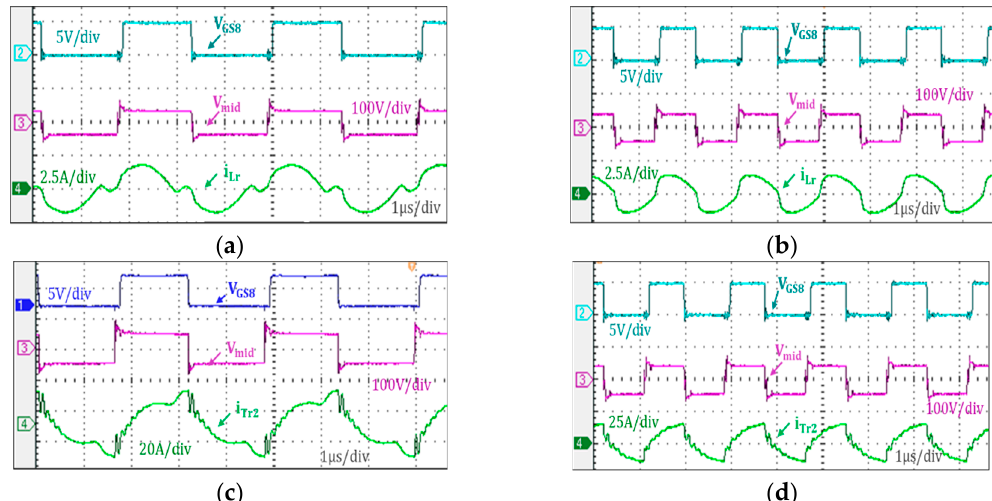
Figure 11. Main experimental waveforms of the reverse mode. ( a ) Waveform of i Lr when f s = 303 kHz; ( b ) waveform of i Lr when f s = 556 kHz; ( c ) waveform of i Tr2 when f s = 303 kHz; ( d ) waveform of i Tr2 when f s = 556 kHz.